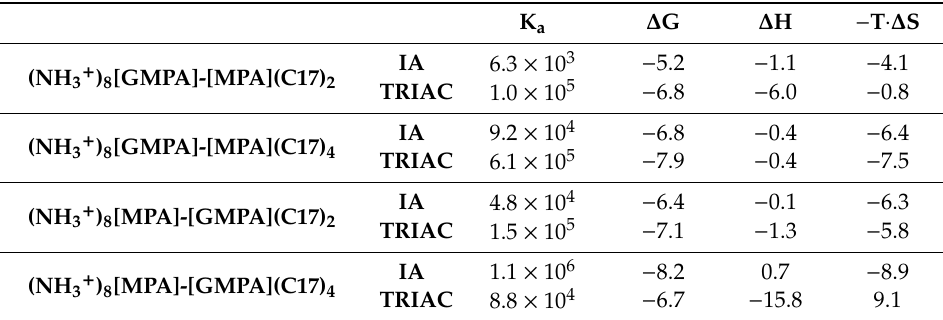
Table 2. Thermodynamic parameters calculated from ITC assays for the interaction between the Janus dendrimers and the compounds IA and TRIAC. K a values are expressed in M − 1 and ∆ G, ∆ H and ( − T · ∆ S) are expressed in kcal / mol. K a ∆ G ∆